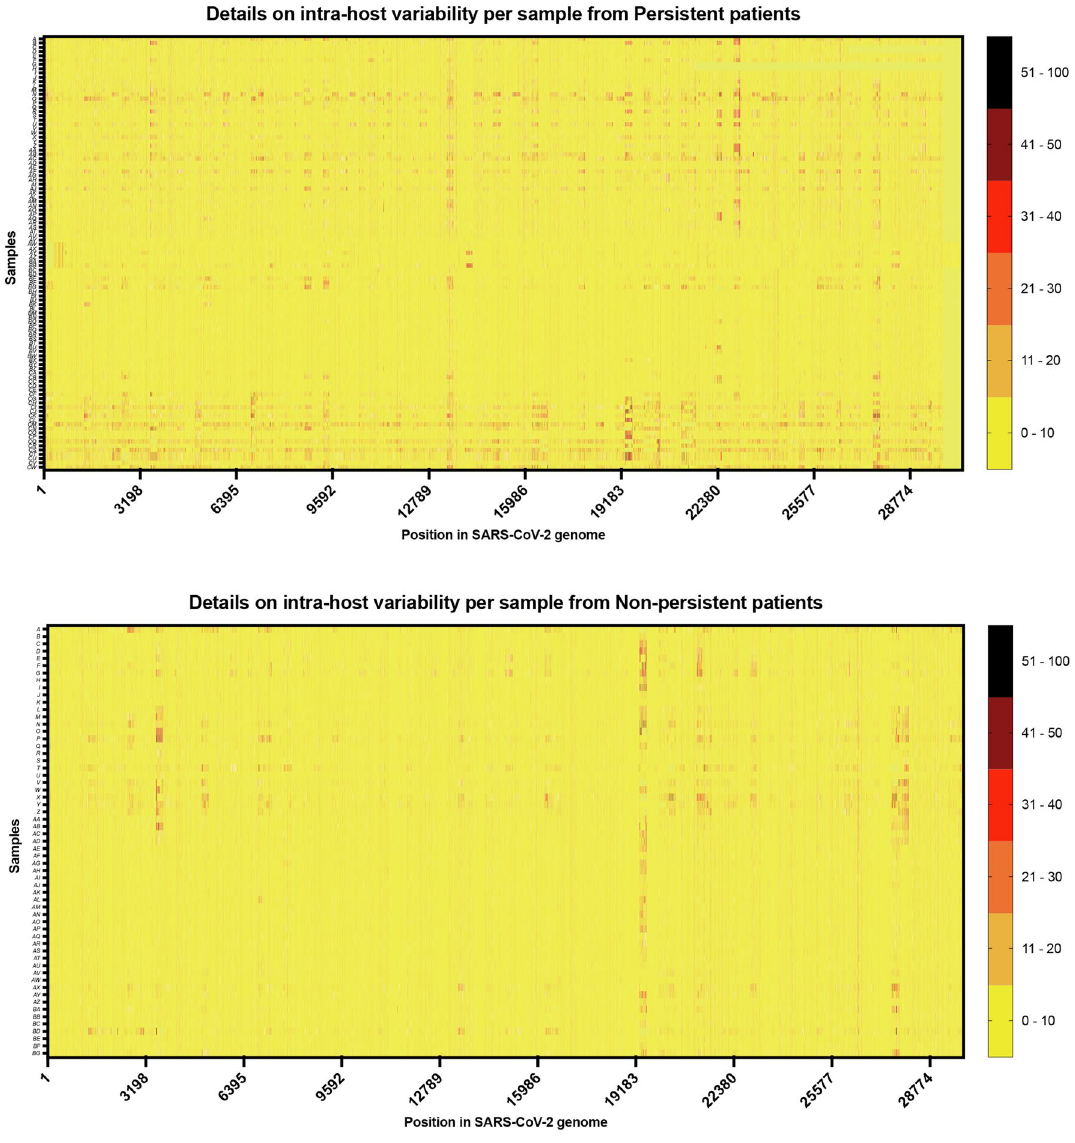
Figure 3. Details on variability for each sequenced samples (Y rows) by position in SARS-CoV-2 genome (X columns). Scale of variability is described at the